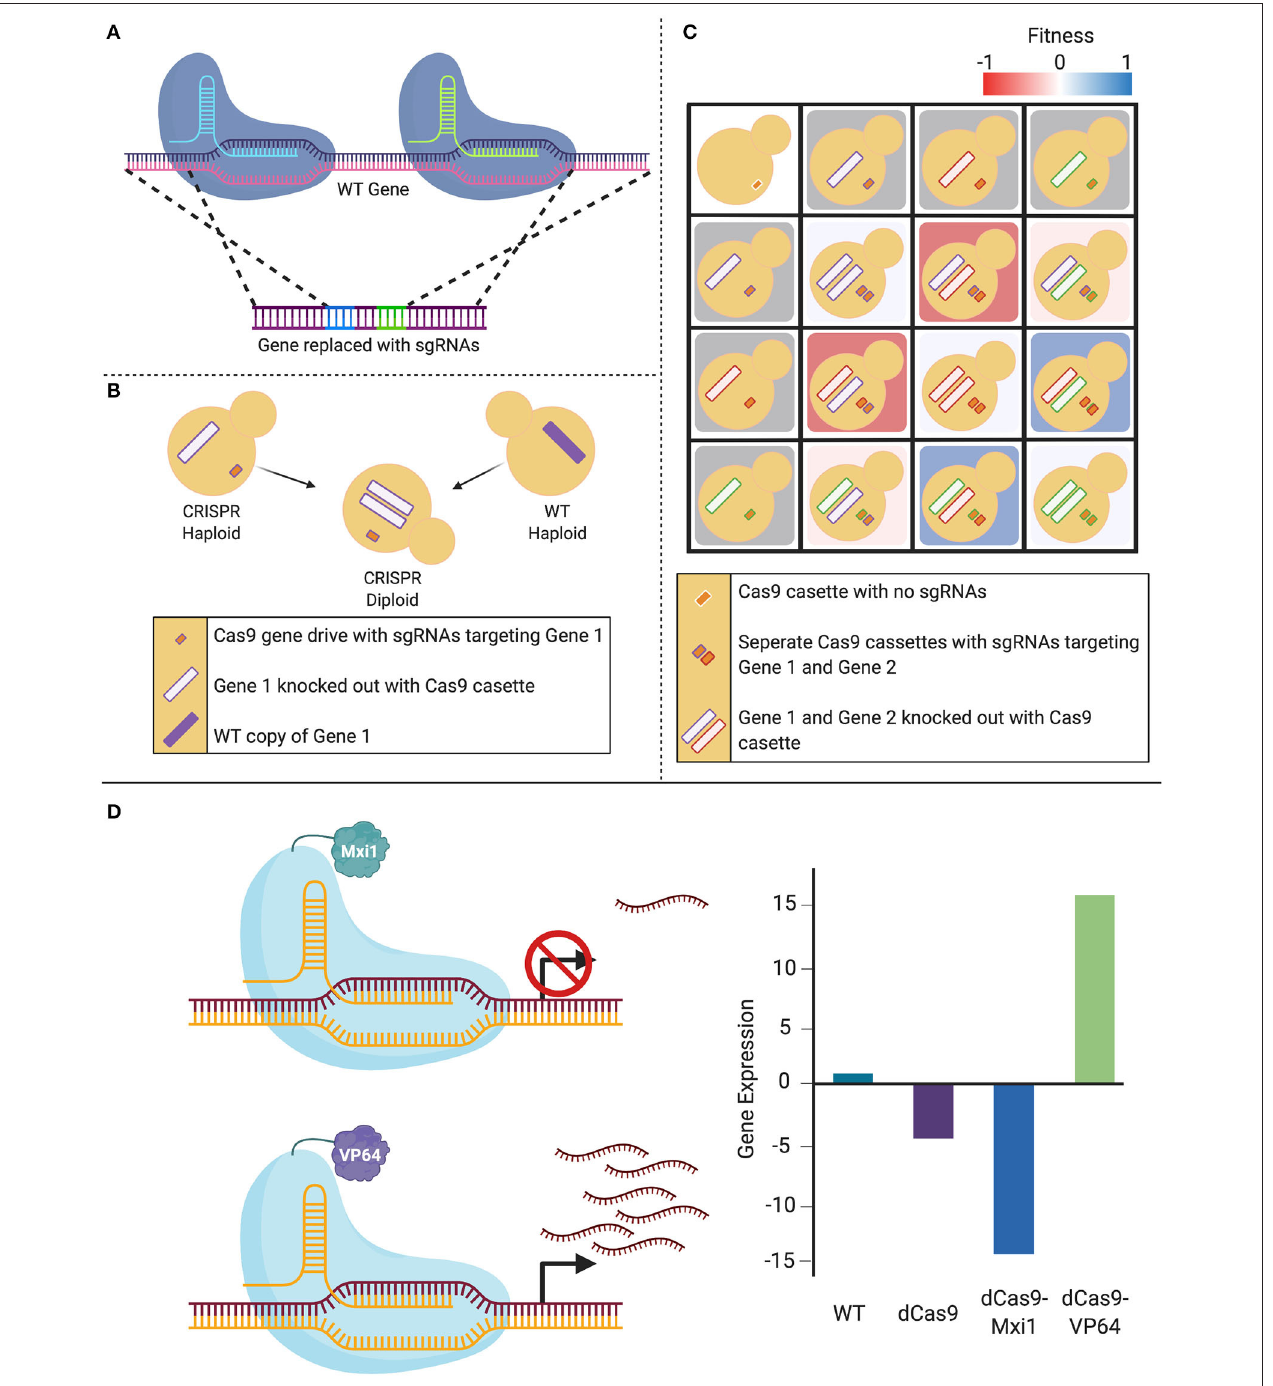
FIGURE 3 | Expansion of CRISPR systems in C. albicans . (A) The CRISPR-Cas9 gene drive array leverages two sgRNAs that target upstream and downstream of the gene of interest, mediating a double-stranded break. This system then uses homology-directed repair to replace the targeted wild-type (WT) gene with a repair template that contains the sgRNAs. (B) When a haploid containing this CRISPR-Cas9 gene drive array is mated to a WT haploid, the WT gene is also deleted in the resultant diploids as the gene drive continues to propagate. (C) This system can be employed to create haploids with gene drives targeting distinct loci that can be mated to form combinatorial double-gene deletions. These double mutants can be used to assess genetic interactions when compared to either their single-mutant counterparts or the non-targeted control. (D) The nuclease-dead Cas9 (dCas9) can be fused to transcriptional modifiers in order to manipulate gene expression. When targeted to a gene promoter, the CRISPR-dCas9 system can reduce gene expression via steric hindrance of the DNA-dCas9 complex preventing RNA polymerase from efficiently transcribing the gene. This repression can be increased with the addition of repressors such as Mxi1 or Nrg1. Alternatively, gene expression can be increased by transcriptional activators such as VP64 that recruit RNA polymerases to the targeted gene.